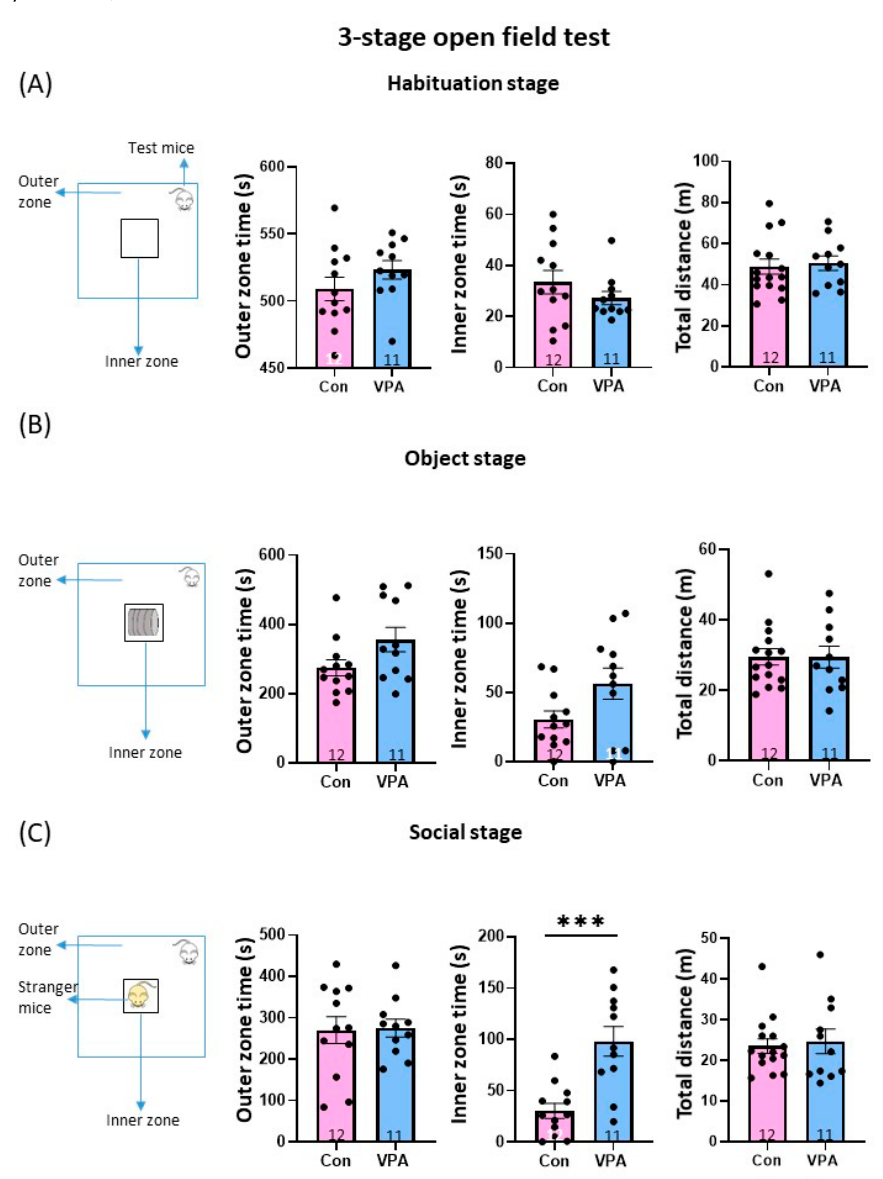
Figure 2. Behavior in the 3-stage open field test. The time in the outer zone, center zone, and total distance were analyzed in control and VPA mice ( A – C ). ( A ) Habituation stage. Behavior in the open field test with no object placed in the center. Time in the outer zone ( left ), inner zone ( middle ), and the total distance ( right ) were measured. ( B ) Object stage. Behavior in the open field with the object (food cage). ( C ) Social stage. Behavior in the open field with the male mice placed in the center. VPA mice spent more time in the inner zone than the control mice. The numbers of mice used in each experiment are indicated in the graphs. Data are the mean ± SEM. *** p < 0.001. Con: control. VPA: valproic acid.